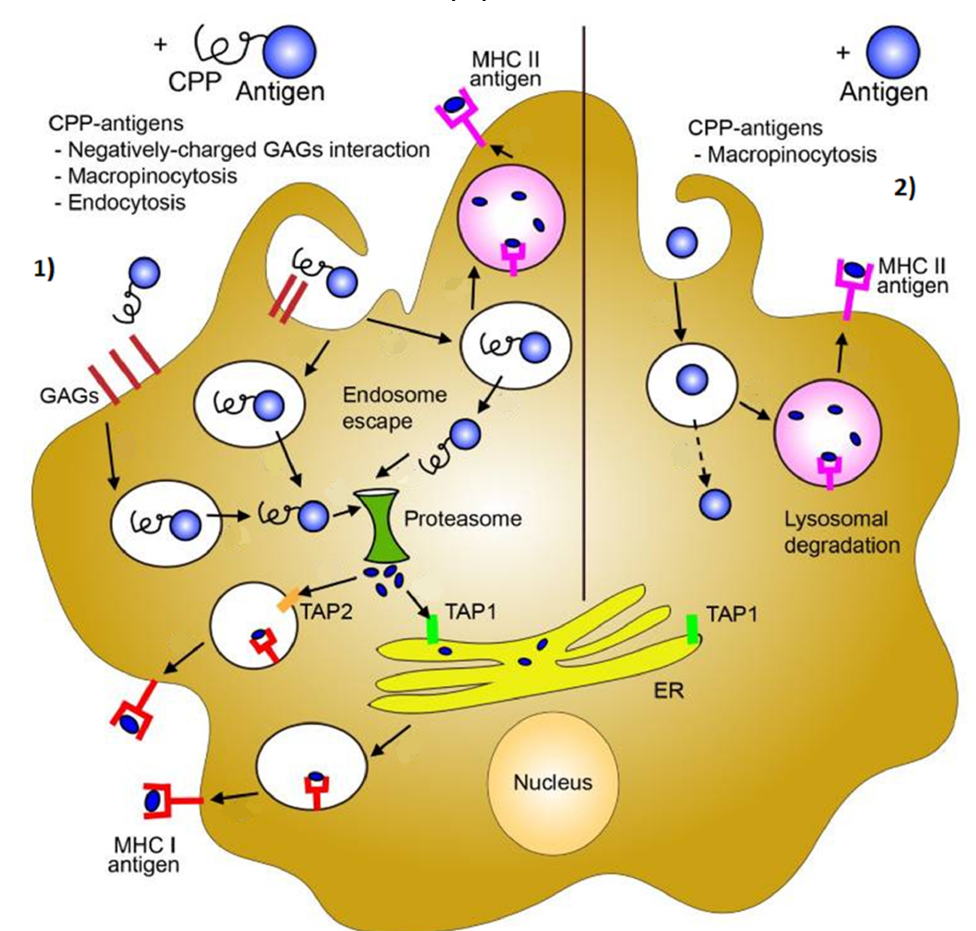
Figure 7. Interaction of cell-penetrating peptides (CPPs) with dendritic cells (DCs), when used as delivery systems for antigens. (1) The CPP–antigen complex interacts with the negatively charged glycosaminoglycans (GAGs) on the surface of dendritic cells. This can trigger the uptake of the complex, usually by endocytosis. When taken up by the cells, the complex is most likely to end up in endosomes. Thanks to the structure of CPPs, the complex can escape the endosomal pathway. After endosomal escape, the complex is degraded in the proteasome, and the antigen is transported to the cell surface by vesicles containing MHC class II receptors. Another possibility is that the antigen is transported though the endoplasmic reticulum-Golgi pathway, and afterwards presented on the cell surface by an MHC class I receptor. If the complex remains in the endosomes, however, it is a subject of lysosomal degradation, after which the antigen is presented on the cell surface by an MHC class II receptor. (2) The free antigen can also undergo endocytosis and enter the cytoplasm of DCs, thus enter the endosomal pathway. Since free antigens are less likely to escape the endosomes, they are subjected to lysosomal degradation, and then presented on the cell surface by MHC class II receptors. Reprinted and edited from [257]. CC BY-NC 4.0 (https://creativecommons.org/licenses/by-nc/4.0/). Accessed 14 March 2021.